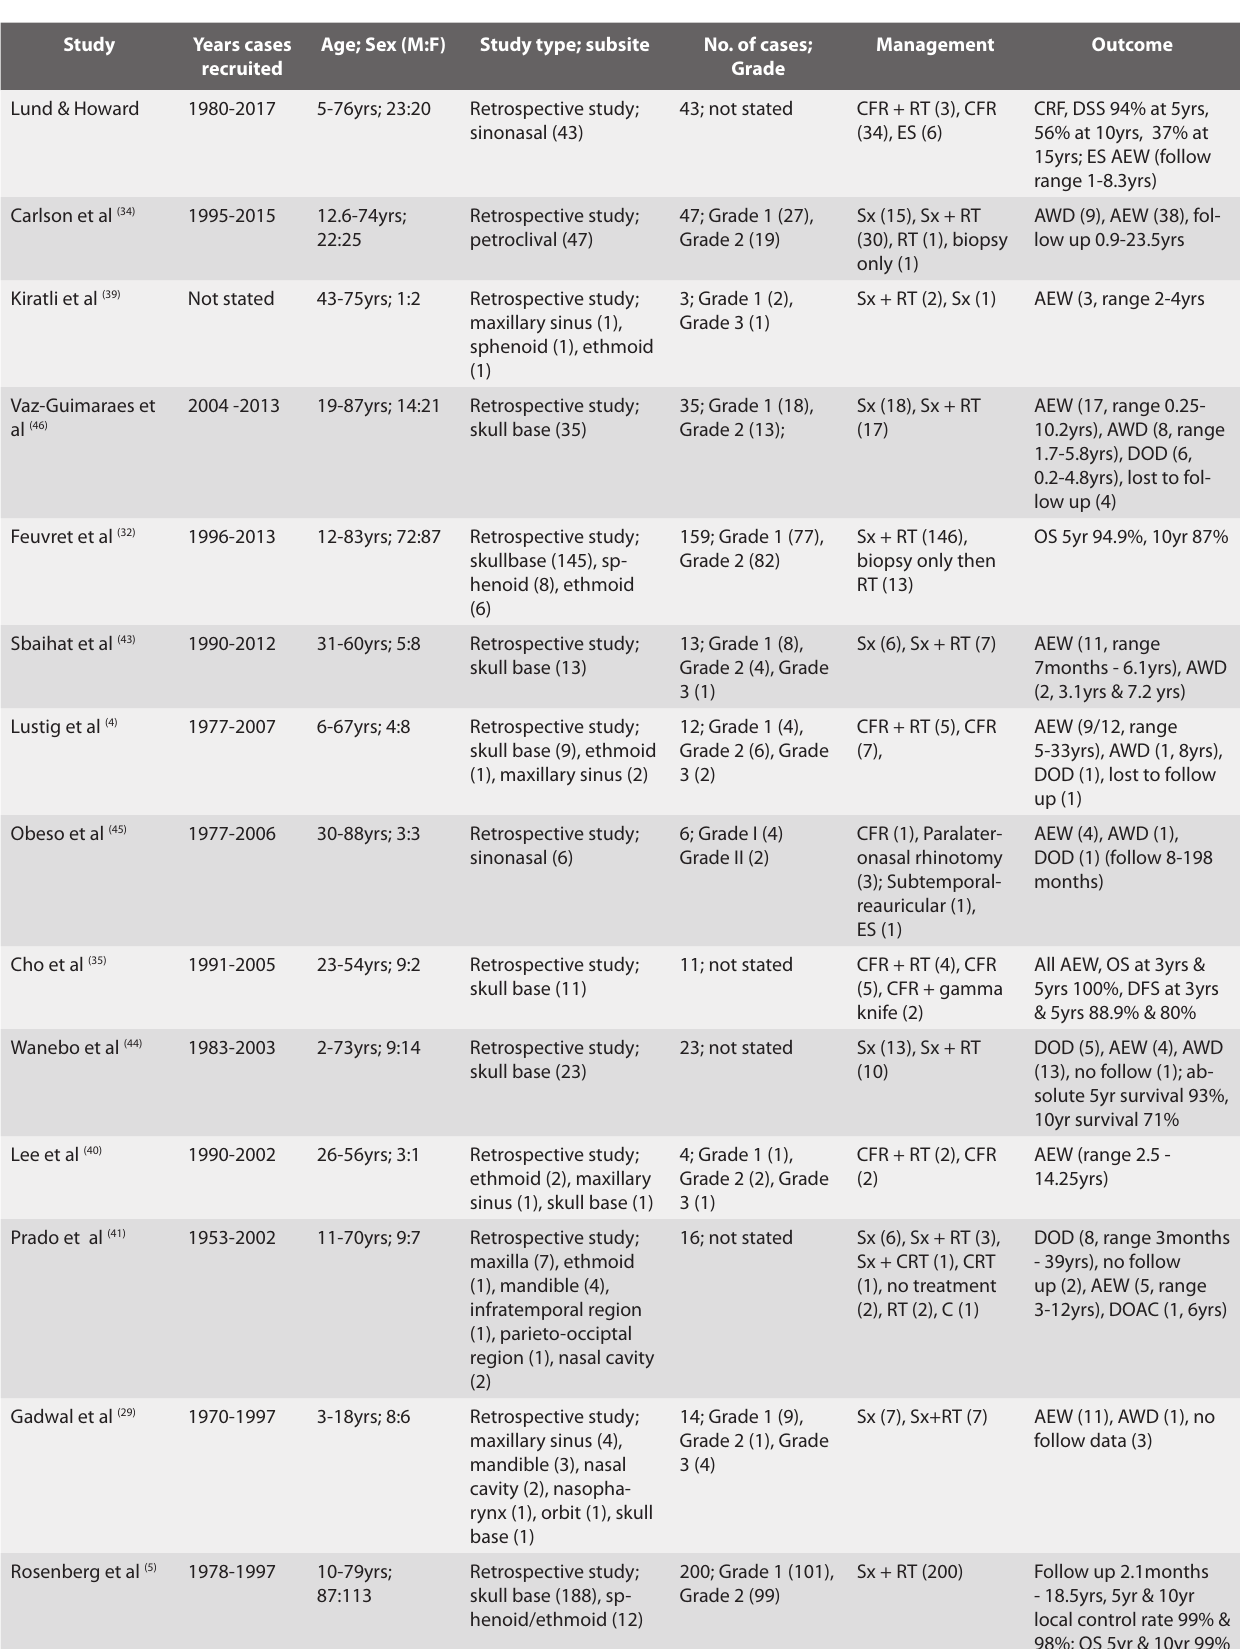
Table 2. Included studies of management of